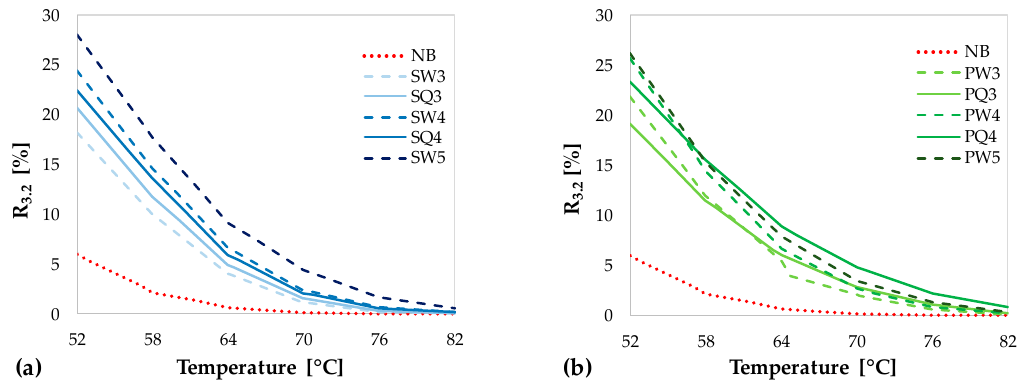
Figure 9. Results of Multiple Stress Creep Recovery (MSCR) tests—percent recovery at 3.2 kPa (RTFO-aged binders): ( a ) SBR-modified binders; ( b ) PBR-modified binders.